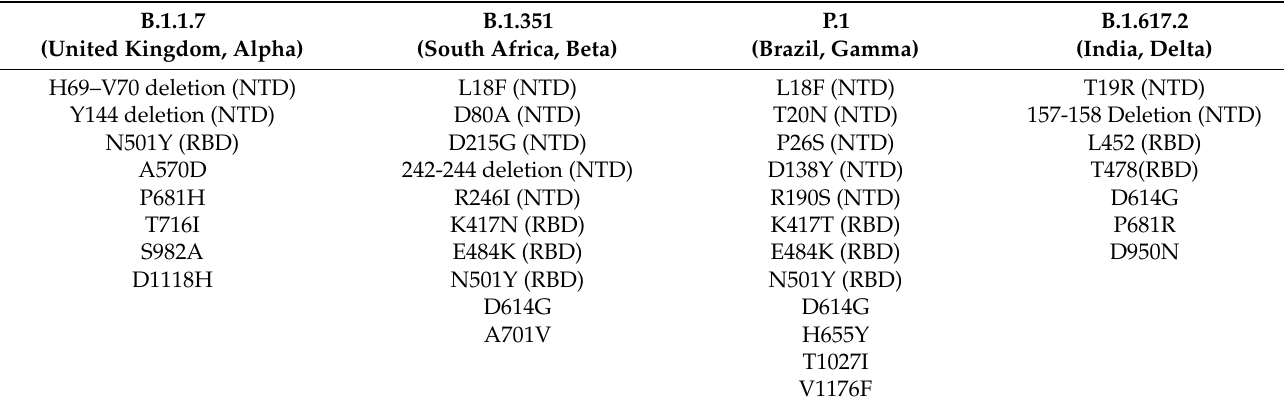
Table 6. Amino acid mutations of SARS-CoV-2 Alpha, Beta, Gamma and Delta variants of SARS-CoV-2 with a focus on Spike protein. The domain to which each mutation belongs is indicated in parentheses.